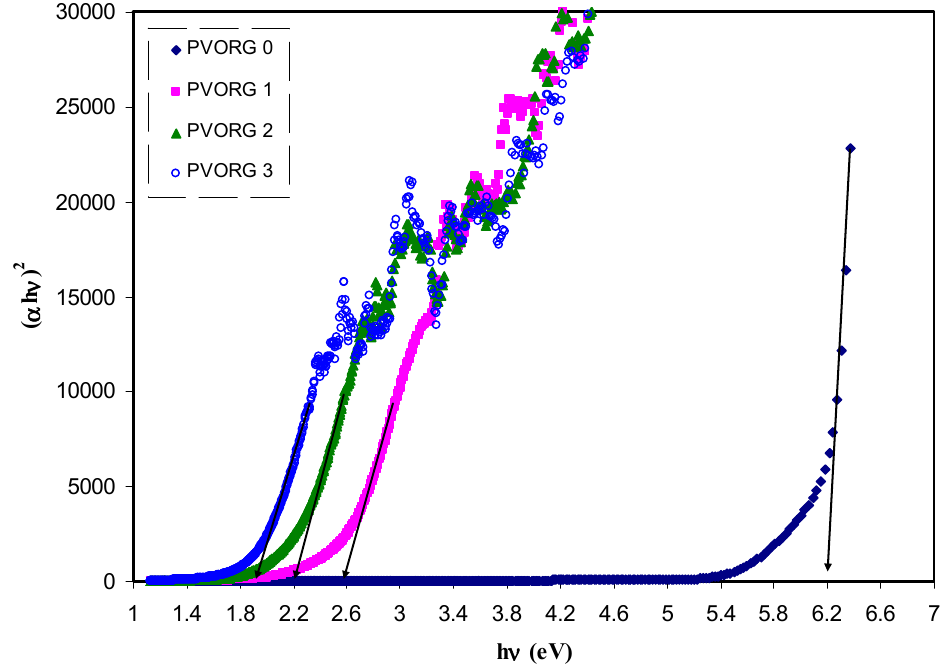
Figure 13. Plot of ( α h υ ) 2/3 vs. photon energy for pure PVA (PVORG0) and PVA composite films.